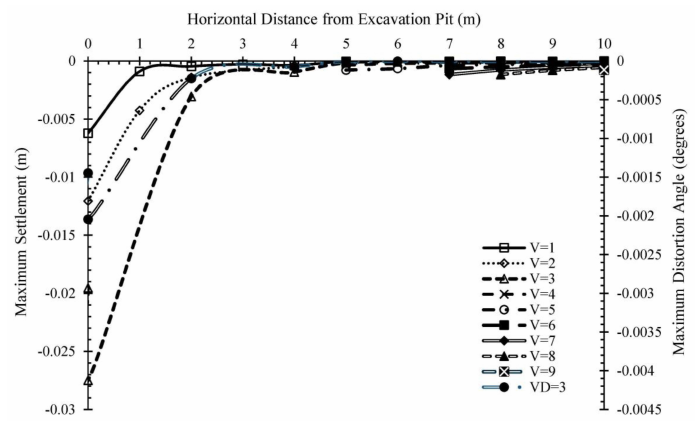
Fig. 5. Settlement at Point B and Angle of Distortion for Scenario